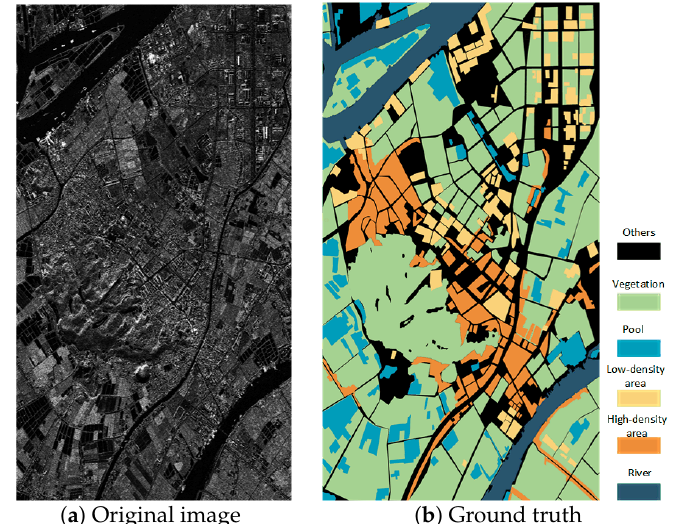
Figure 6. DataSet2 (there are 6 categories, but only 5 are